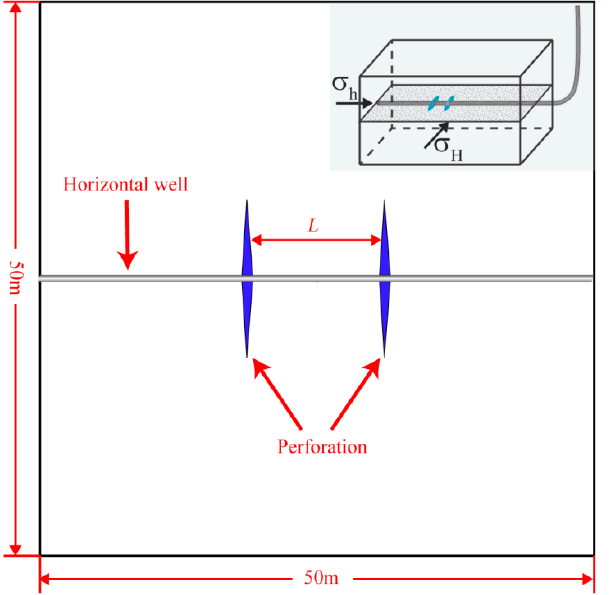
Figure 2. Geometric model: contains two perforations (perforation spacing: L , length: 1 m, direction: perpendicular to minimum principal stress).